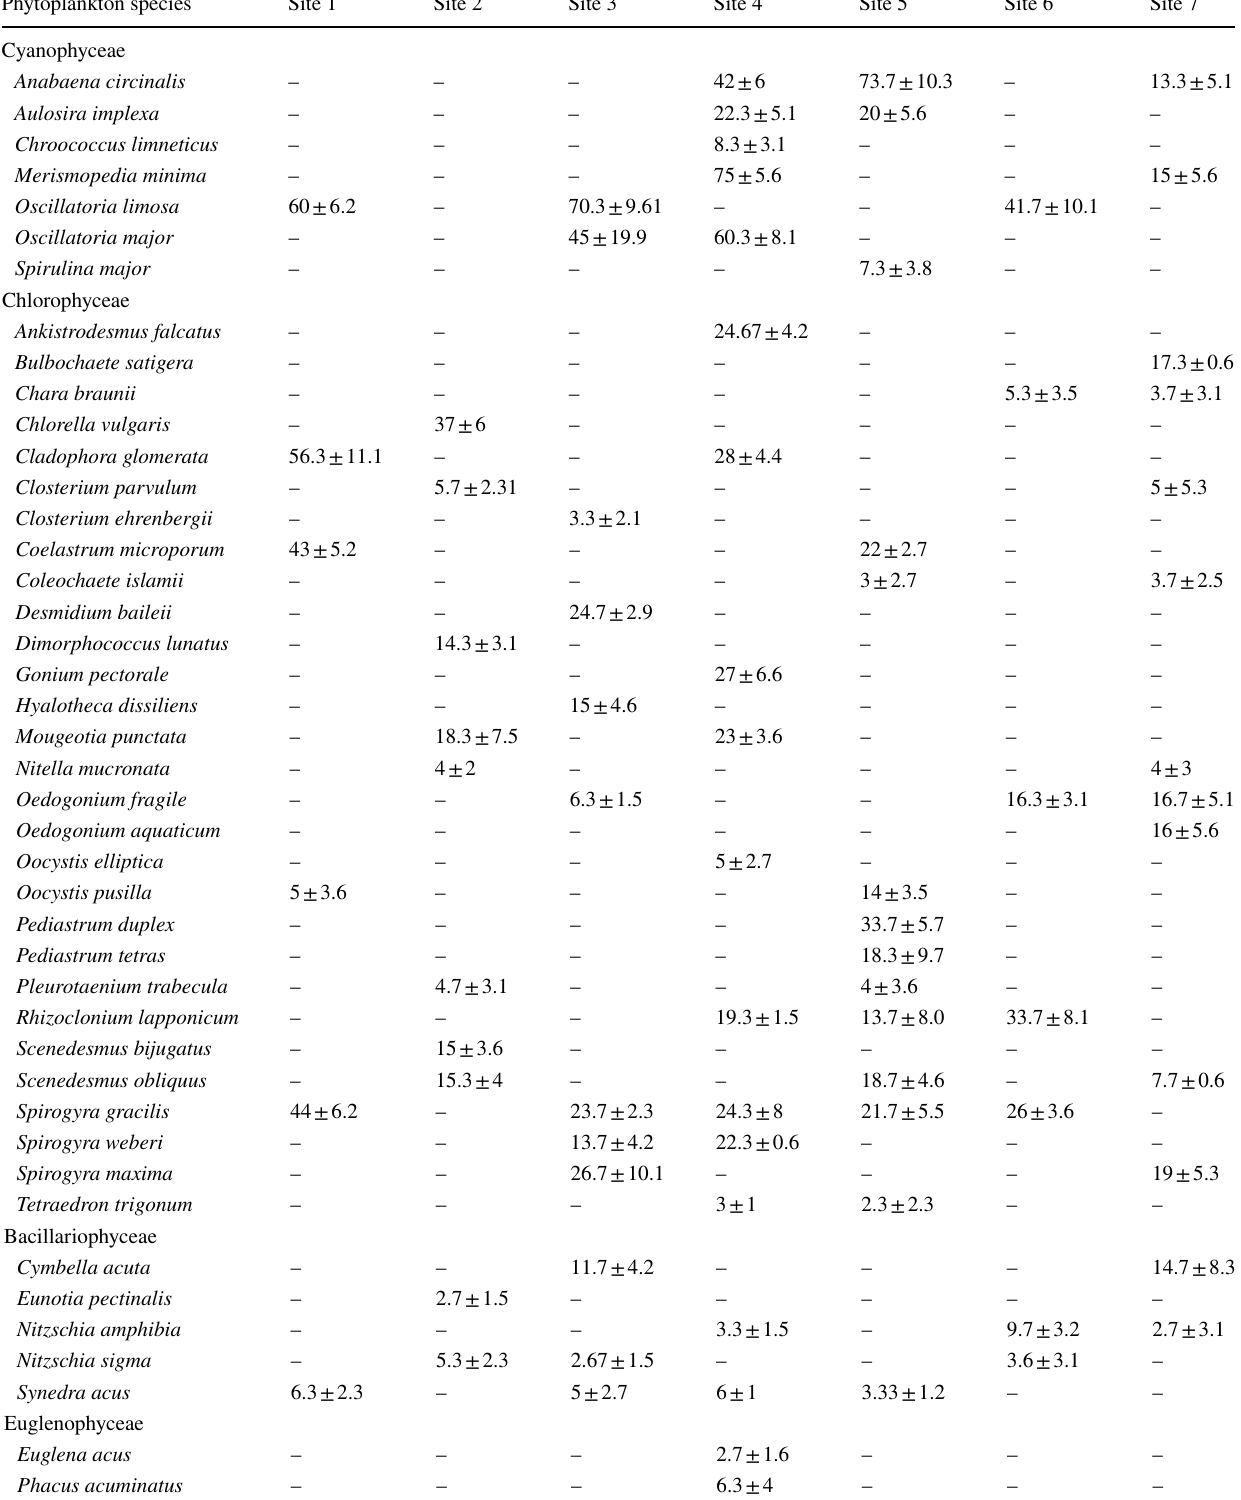
Table 7 Phytoplankton diversity and density (number mL −1 ) in selected seven study sites Phytoplankton